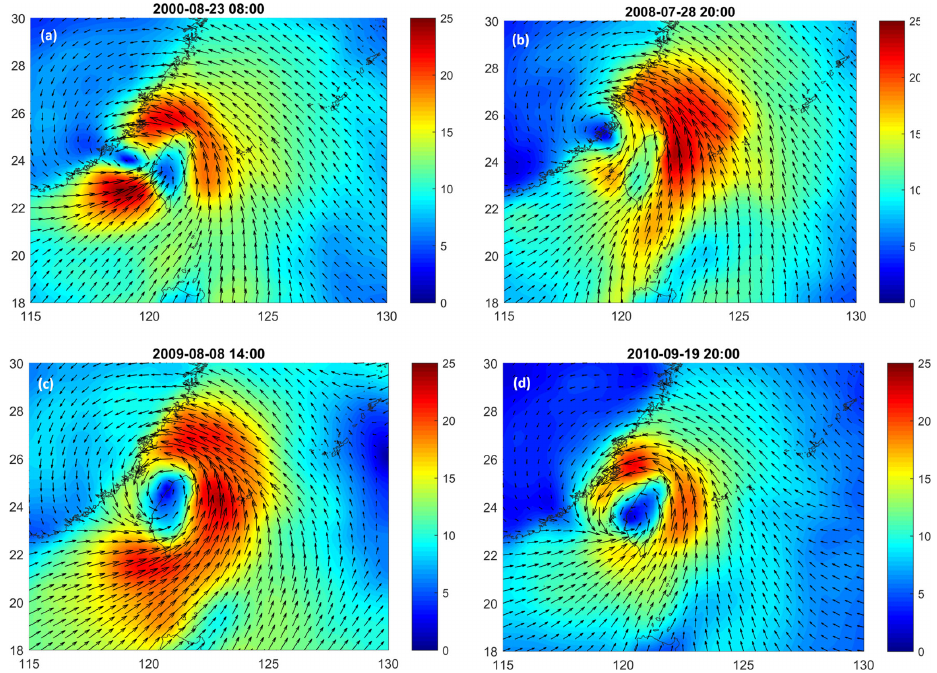
Figure 8. Wind patterns at the time close to the start of the SST drop. (a) Typhoon Bilis in 2000. The SST started to decrease on 23 Au- gust 2000 at 10:00UTC+8. The wind pattern was observed on 23 August 2000 at 08:00UTC+8. (b) Typhoon Fungwong in 2008. The SST started to decrease on 28 July 2008 at 18:00UTC+8. The wind pattern was observed on 28 July 2008 at 20:00UTC+8. (c) Typhoon Morakot in 2009. The SST started to decrease on 8 August 2009 at 13:00UTC+8. The wind pattern was observed on 8 August 2009 at 14:00UTC+8. (d) Typhoon Fanapi in 2010. The SST started to decrease on 19 September 2010 at 22:00UTC+8. The wind pattern was observed on 19 September 2010 at 20:00UTC+8.